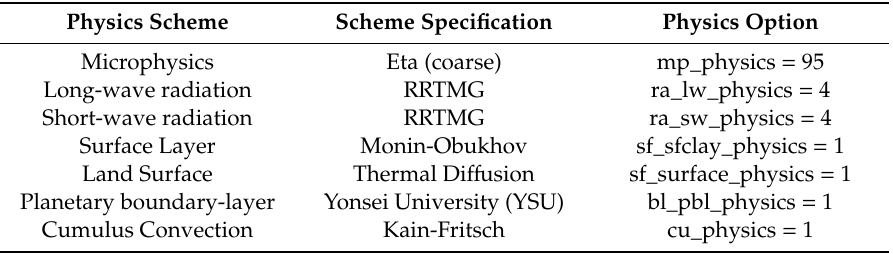
Table 2. WRF physics scheme specifications and options used in the simulations. (RRTMG: rapid radiative transfer model for